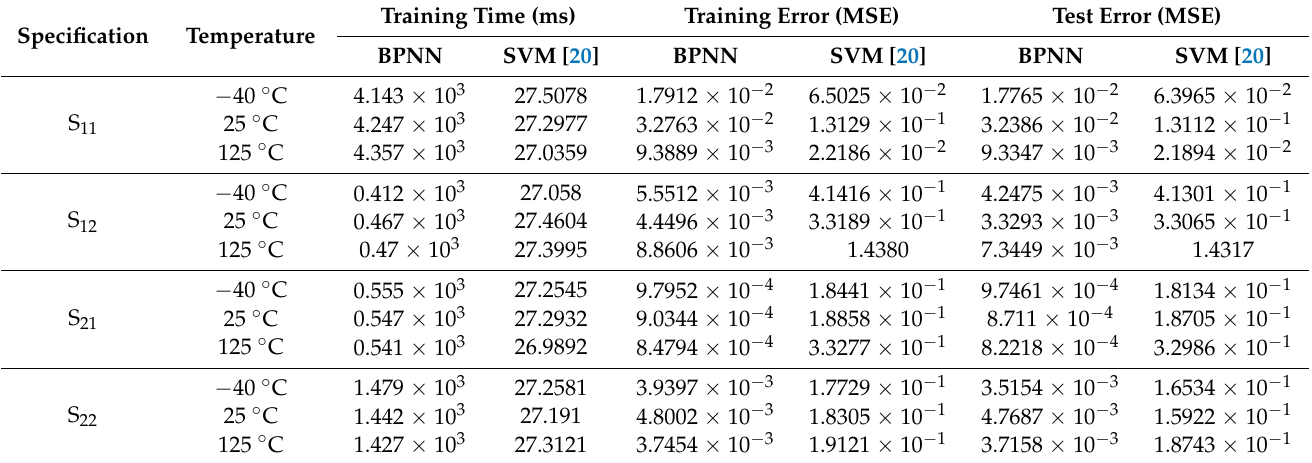
Table 1. Comparison of modeling results of the BPNN and